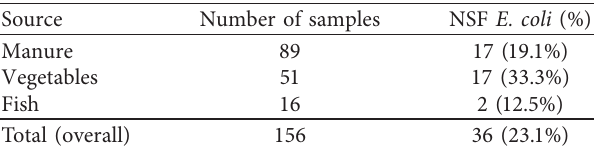
Table 1: Distribution of proportions for NSF E. coli from different sources ( n �